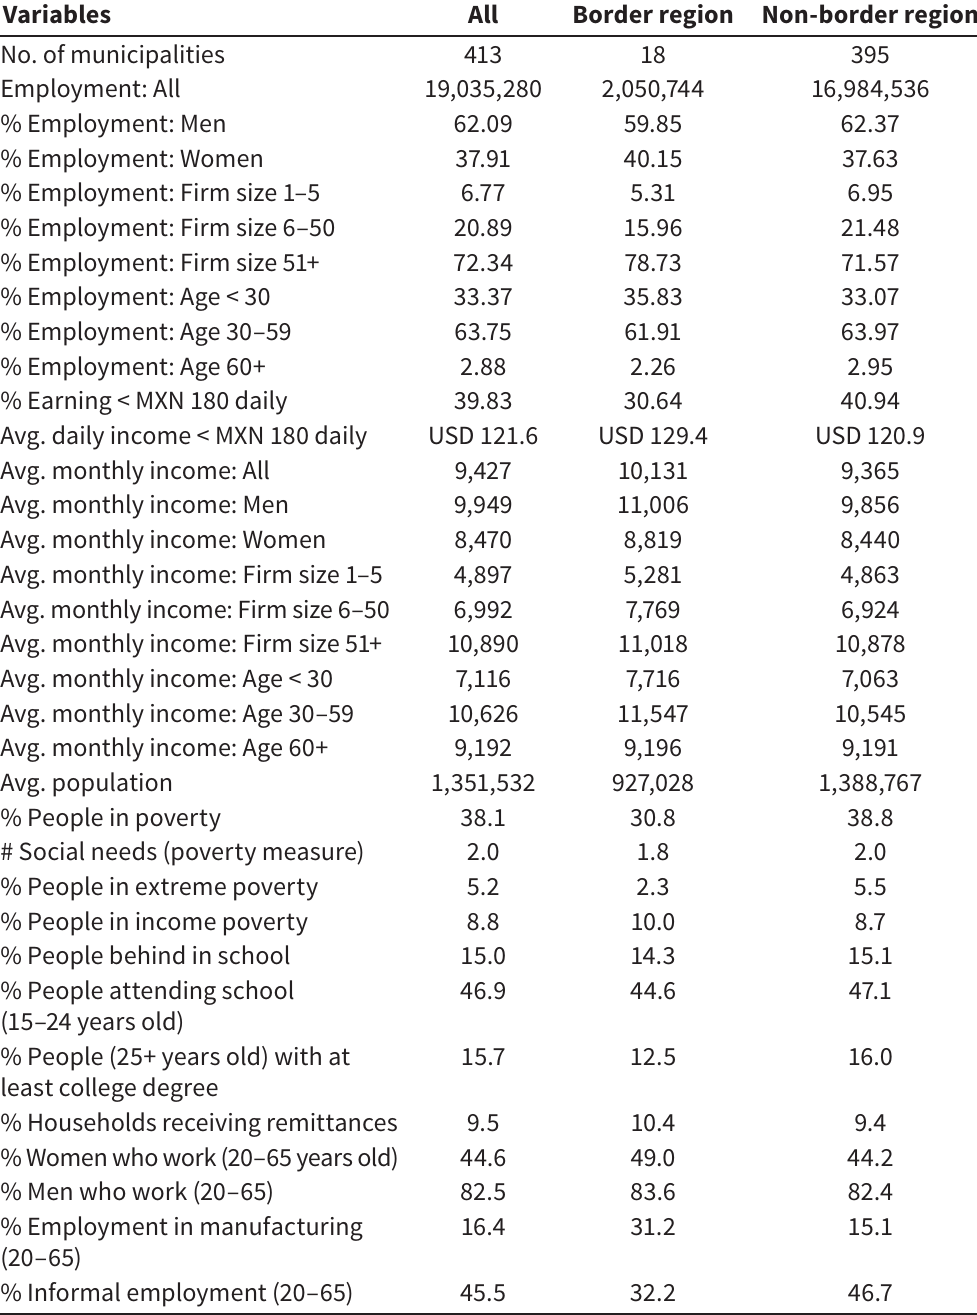
Descriptive statistics using IMSS data (September